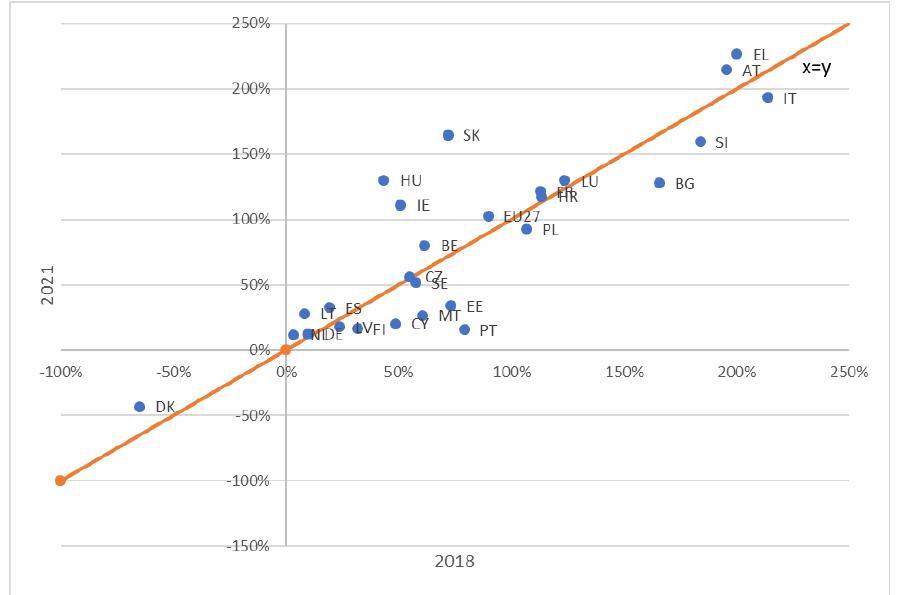
Figure 5. IPD of 2018 and 2021 compared (percentage of 2020 GDP). Source: Author’s calculations and (Eurostat 2021).